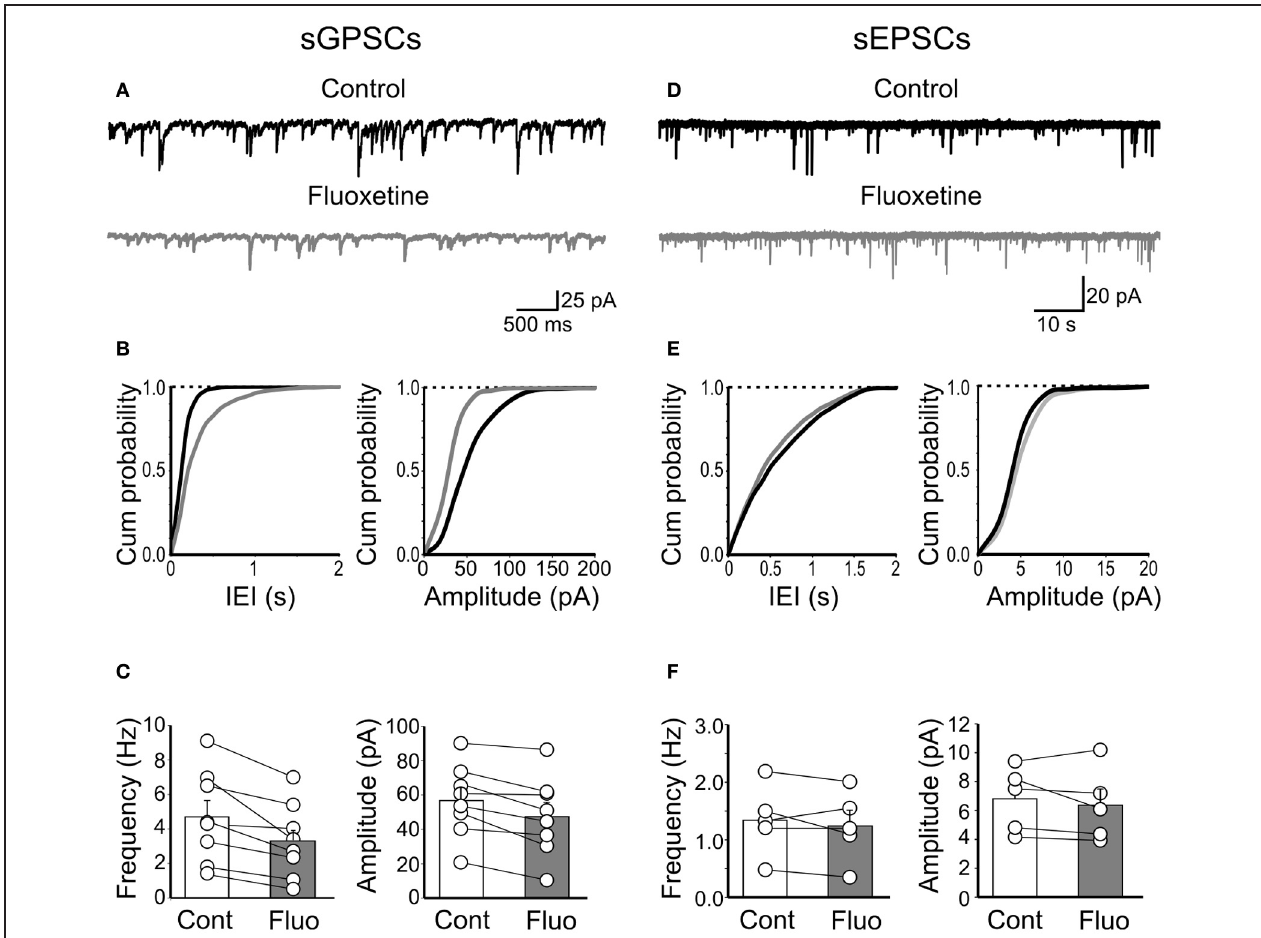
amplitude for the cell shown in (A) before (black) and during (grey) application of fluoxetine. (C) Summary plots of the mean frequency ( n = 8; p = 0 . 007) and amplitude ( n = 8; p = 0 . 004) of all cells tested ( ± SEM). (D–F) As in (A–C) but for sEPSCs. No significant differences in frequency ( n = 5; p = 0 . 4) or amplitude ( n = 5; p = 0 . 38) were